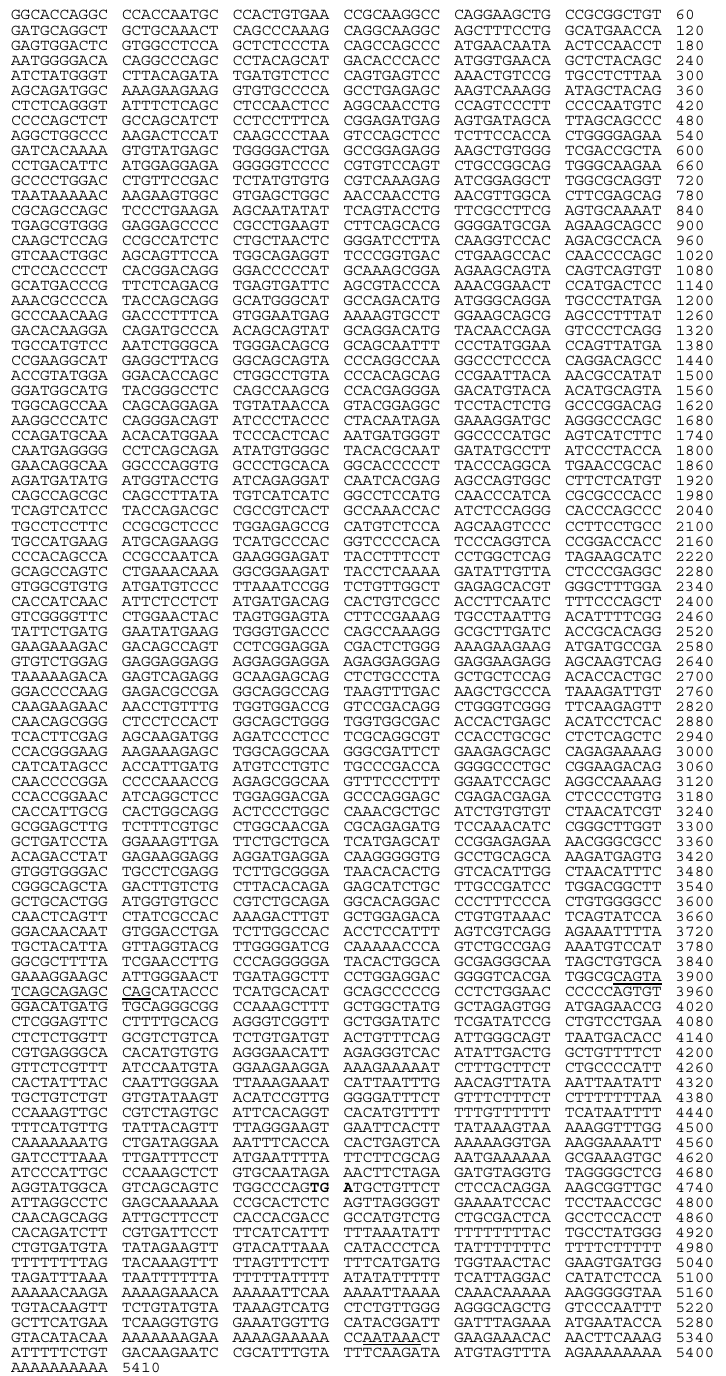
Figure 4. Analysis of the di ff erent parts of the rat 6A3-5 cDNA. The nucleotide sequence (5410bp) with the poly-A signal (AATAAA) underlined. The poly-A tail is given at the end of the sequence whereas the stop codon (TGA) is shown in bold (at position 4708). An example of poly-CAG repeats is given between 3896–3913. The 3 (cid:1) -untranslated region (3 (cid:1) -UTR) is 681bp. The uppermost 5 (cid:1) coding region, with the initiation codon and the 5 (cid:1) -UTR, has not been cloned yet.